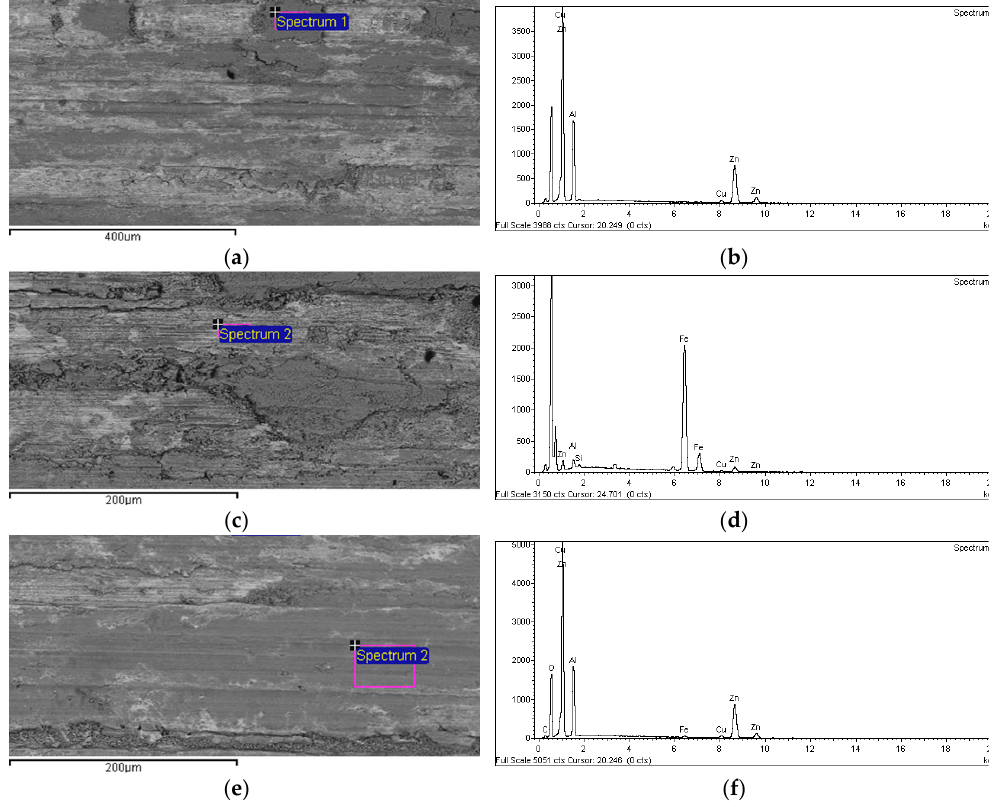
Figure 8. SEM micrographs and EDS analysis of the worn surfaces: ( a ) ZA27 alloy SEM micrograph; ( b ) ZA27 alloy EDS analysis; ( c ) ZA27/5%SiC composite SEM micrograph; ( d ) ZA27/5%SiC composite EDS analysis; ( e ) ZA27/5%SiC/3%Gr hybrid composite SEM micrograph; ( f ) ZA27/5%SiC/3%Gr hybrid composite EDS analysis.